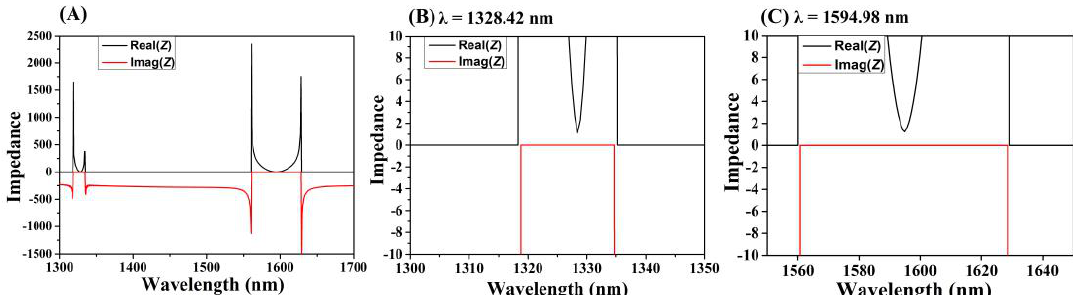
Figure 3. ( A ) Effective impedance diagram of the cross-circle monolayer graphene unpatterned Figure 3. ( A ) E ff ective impedance diagram of the cross-circle monolayer graphene unpatterned perfect absorber. ( B ) E ff ective impedance amplification at 1328.42 nm. ( C ) E ff ective impedance amplification perfect absorber. ( B ) Effective impedance amplification at 1328.42 nm. ( C ) Effective impedance at 1594.98 amplification at 1594.98 nm.